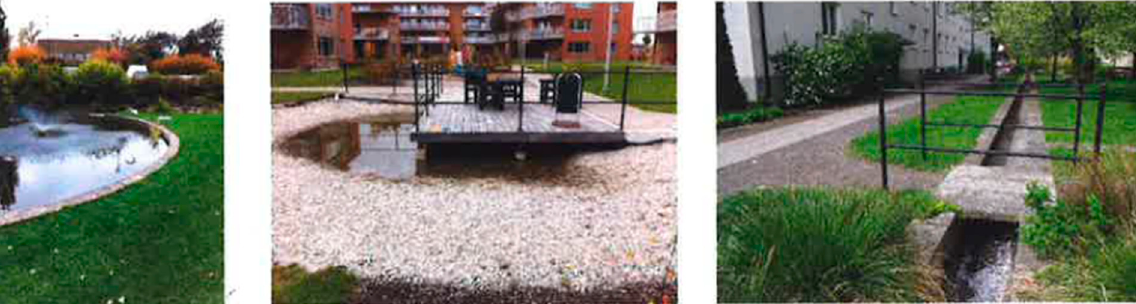
Figure 3. Photomontage question asking the respondents about their neighborhood preference for living with or without BGS. Photographs by Misagh Mottaghi.